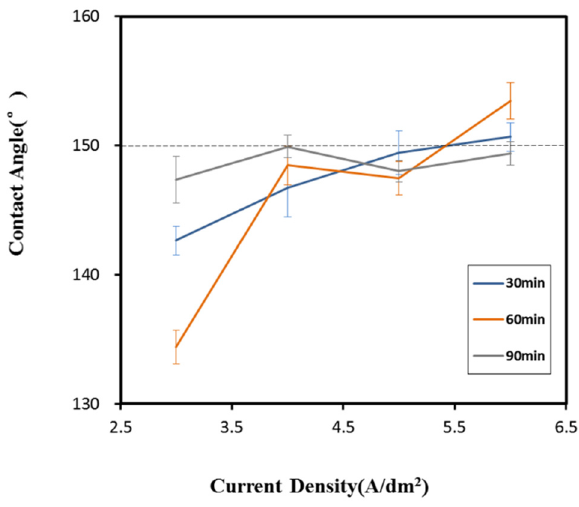
Figure 6. Plating current density versus contact angle for the prepared samples.